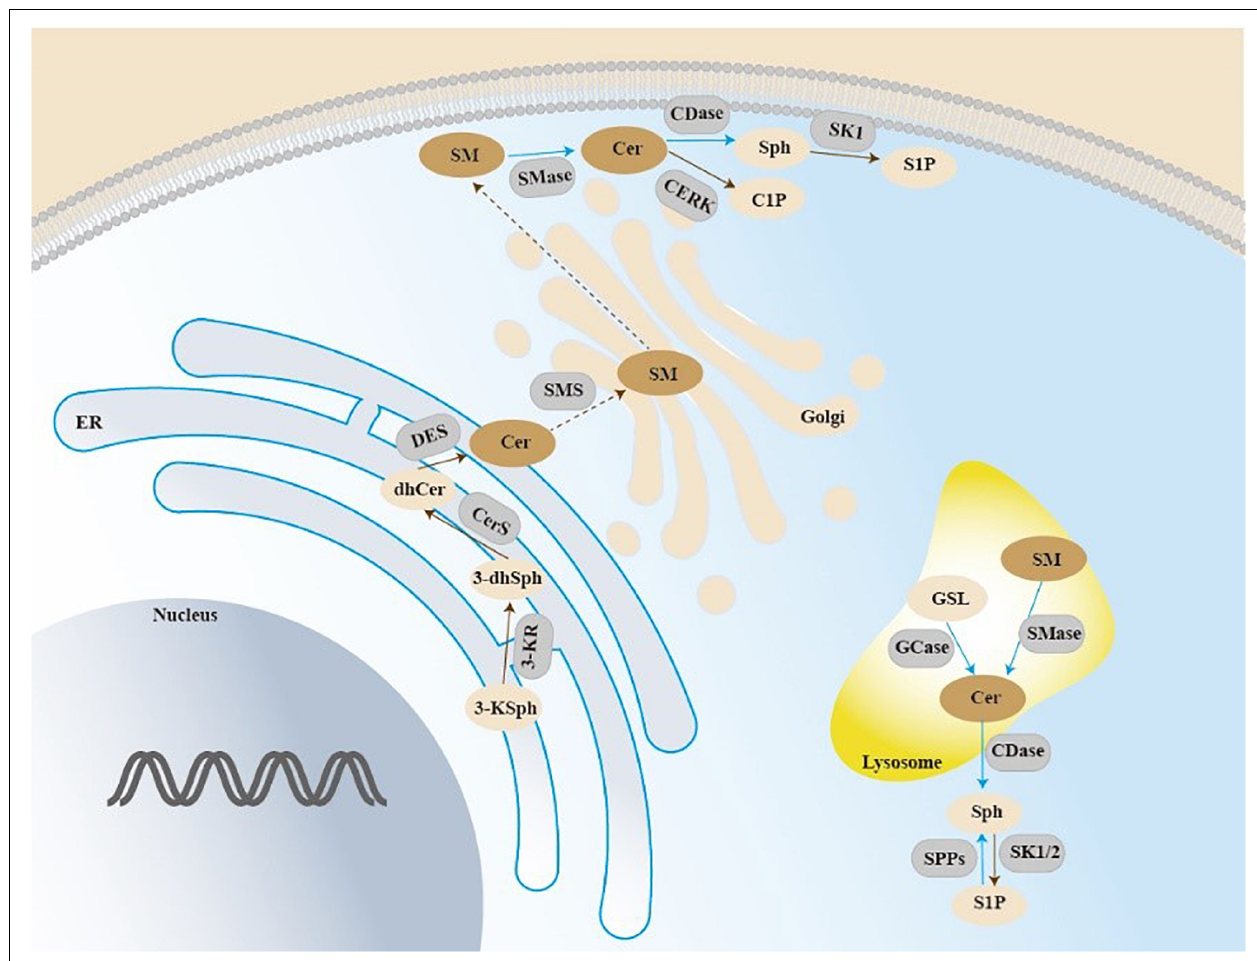
FIGURE 2 | Sphingolipid